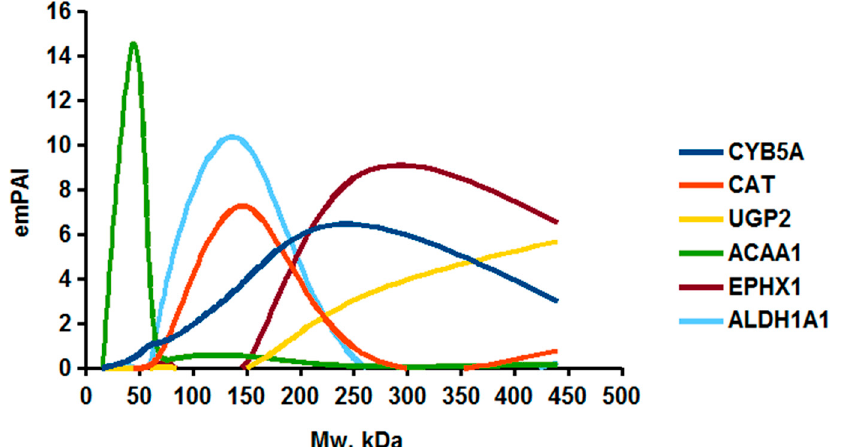
Figure 4. Co-fractionation profiles of CYB5A and its protein partners in the liver tissue lysate (ac- cording to the data in [36,50]). The profiles were plotted using points, which correspond to average molecular-weight values of SEC-fraction MW: 15, 30, 48, 60, 90, 130, 290, and 400 kDa. The x -axis shows the MW of the SEC fractions, and the y -axis shows the semi-quantitative assessment of a protein content in each SEC fraction. LC-MS/MS analysis was performed on an Orbitrap Fusion hybrid orbital mass spectrometer (Thermo Scientific) in the positive ionization mode in an NSI (nanospray ion) source (Thermo Scientific). The selection of proteins had Mascot score values > 50. The